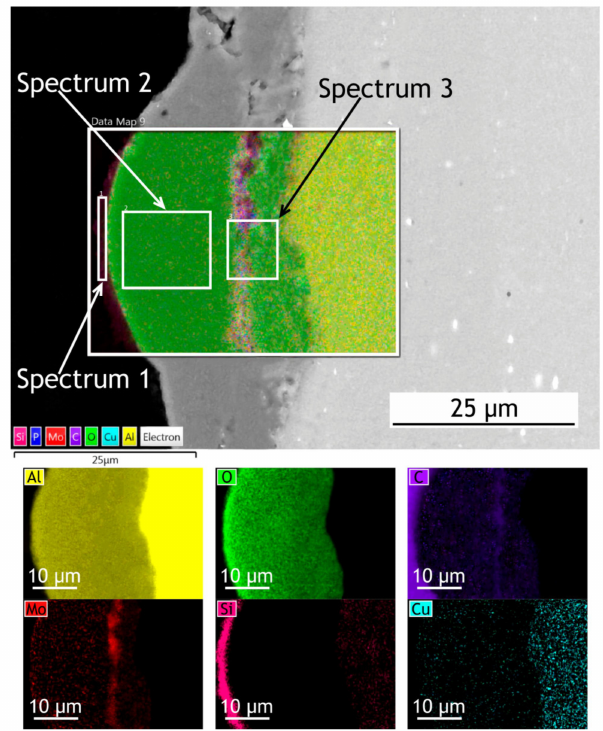
Figure 11. SEM image and EDX maps of the PEO-coating’s cross-section after 30 days of atmospheric